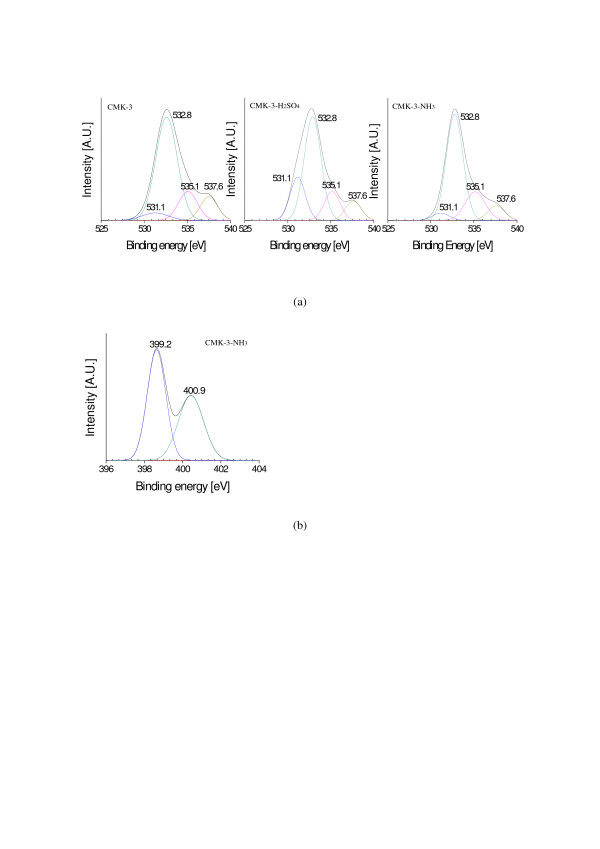
XPS spectra of CMK-3, CMK-3-H2SO4, and CMK-3-NH3 samples: (a) O1s spectrum and (b) N1s spectrum.